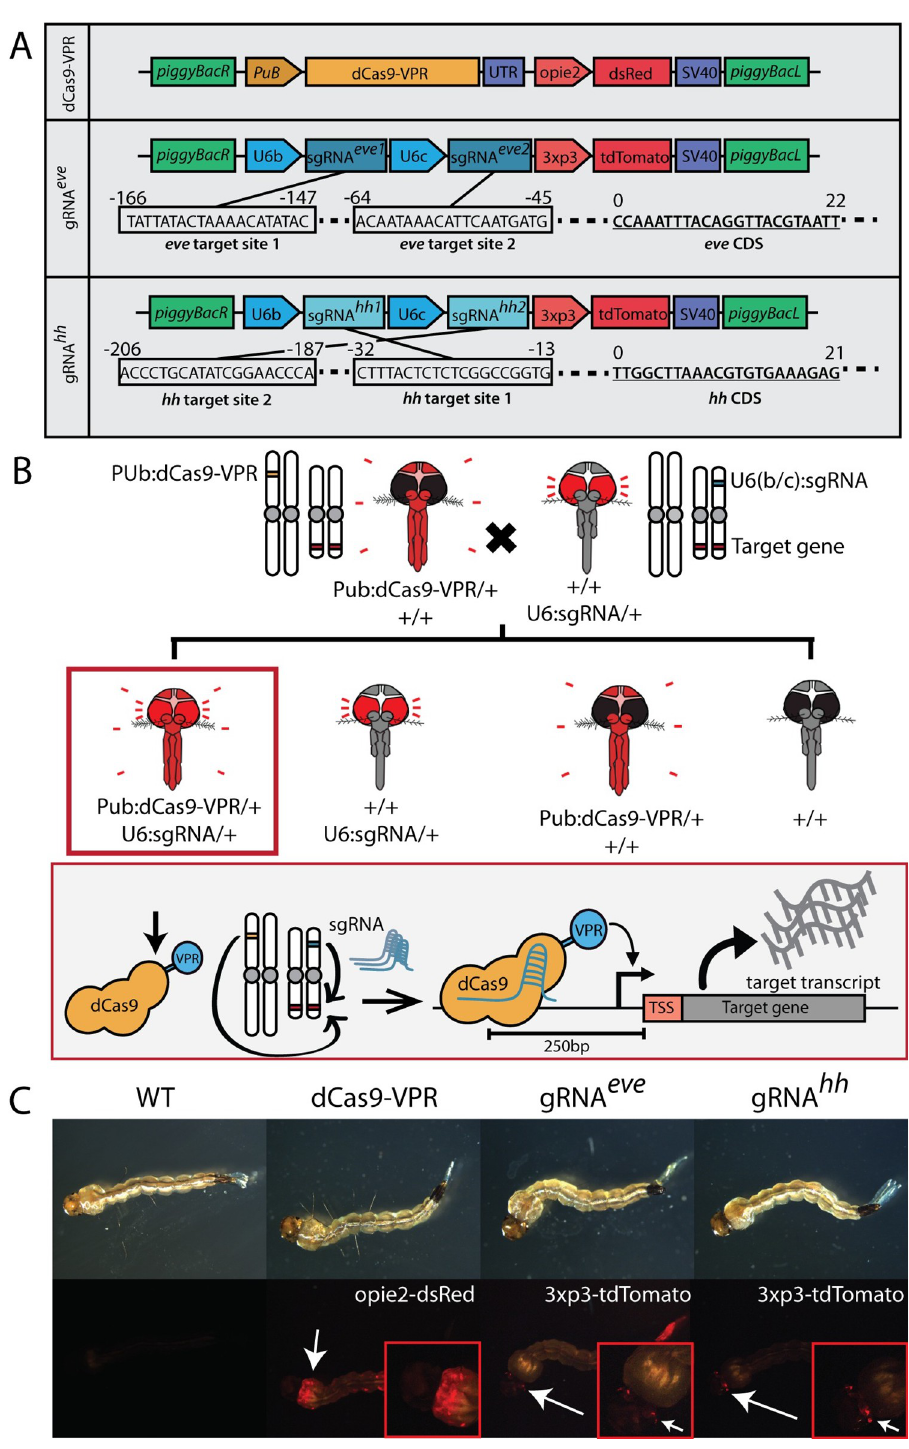
Fig 1. CRISPRa system transgenic line design, genetic crosses, and marker expression in Ae . aegypti . A) A binary CRISPRa system was designed using two separate transgenic Ae . aegypti lines that when crossed, result in transheterozygous individuals expressing both dCas9-VPR and sgRNAs and have upregulated expression of the target gene. B) The transgenic lines used in this study include one line expressing dCas9-VPR under a polyubiquitin promoter, a sgRNA line targeting eve , and a sgRNA line targeting hh . The sgRNA lines were designed to express two distinct sgRNAs targeting the same promoter region of the respective target gene. C) dCas9 and sgRNA lines were marked with opie2-dsRed and 3xP3-tdTomato,